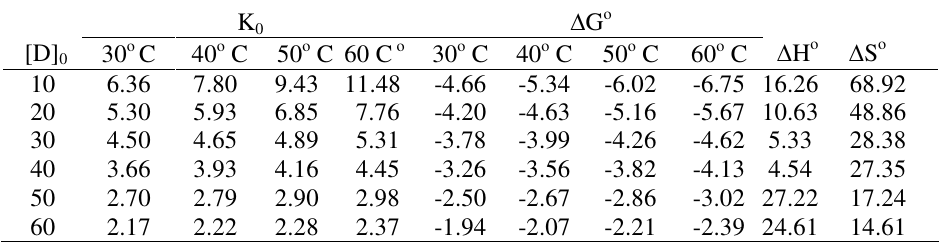
Table 6. Equilibrium constant and thermodynamic parameters for the adsorption of dye onto